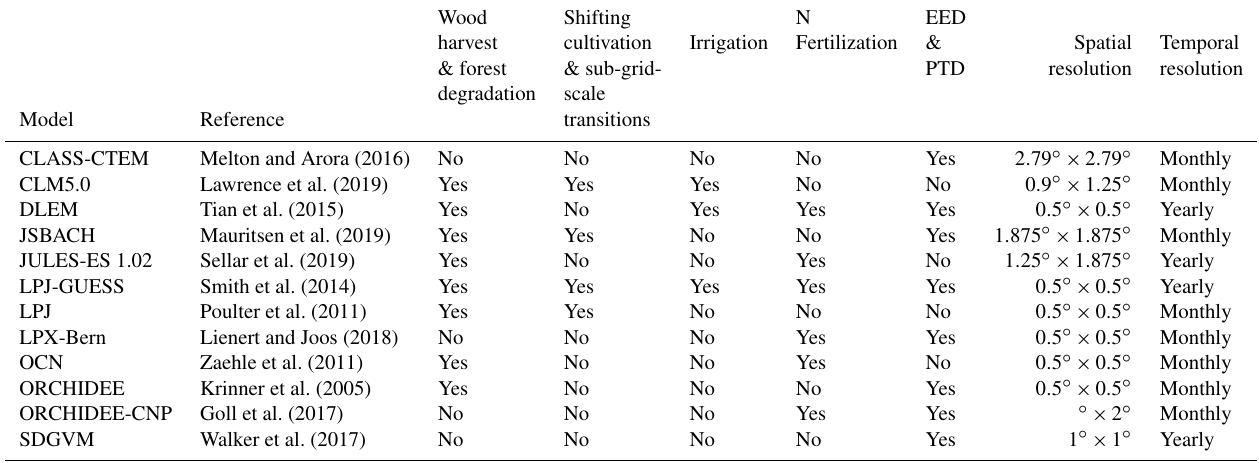
Table 2. Overview of the TRENDY v8 DGVM model output provided and used in this study and of selected processes included that are relevant for the f LULCC . Also indicated is if a plausible derivation of the environmental equilibrium difference (EED, Eq. 5 and Sect. 2.2.1) and “present-day” vs. “transient” environmental conditions difference (PTD, Eq. 6 and Sect. 2.2.1) was